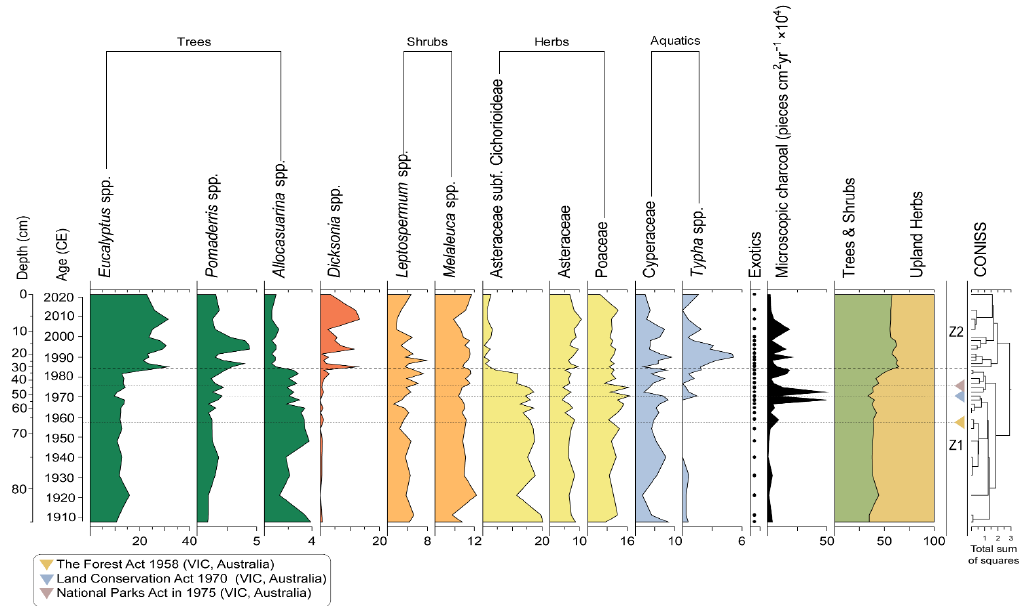
Figure 3. Terrestrial pollen stratigraphy by depth (cm) and age (CE) including microscopic charcoal accumulation calculated by known inputs of exotic Lycopodium spores. Two significant zones were determined (Z1 & Z2) using CONISS on the terrestrial pollen data. Here, dominant forest trees are represented in dark green, disturbance indicator, Dicksonia spp. in orange, dominant shrubs in orange, dominant herbs in yellow, abundant aquatic plants in blue and exotics as presence shown as black dots. Terrestrial pollen abundance was summed into two groups: trees & shrubs (light green) and upland herbs (gold). For interpretation of the references to colour in this figure legend, the reader is referred to the web version of this article.